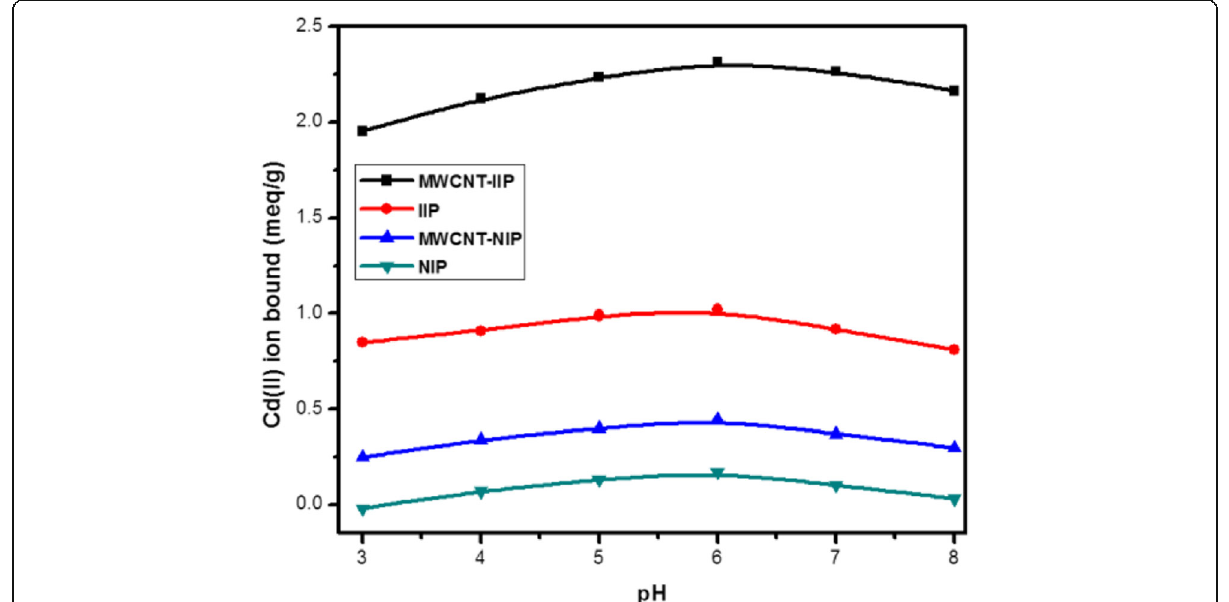
Fig. 16 Effect of pH on the adsorption of Cd(II) ion on MWCNT-IIP, IIP, and MWCNT-NIP NIP